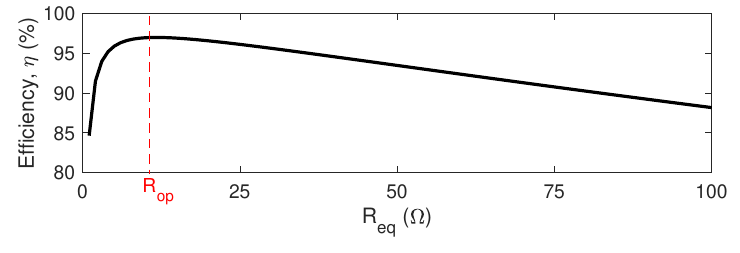
Figure 7. Efficiency, η vs. R eq .